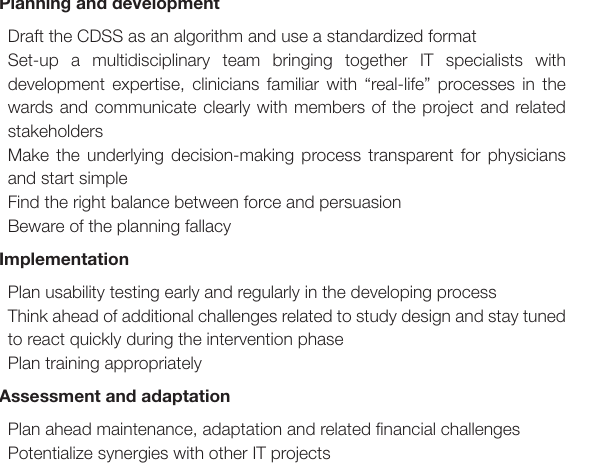
Figure 1A the final algorithm drawn in